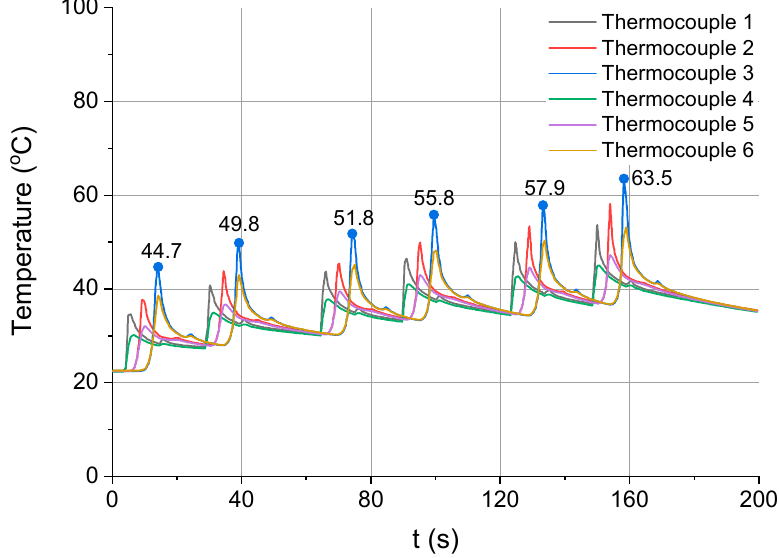
Figure 12. Temperature vs. time for strategy 4 (six passes of the tool with a p = 0.5 mm).